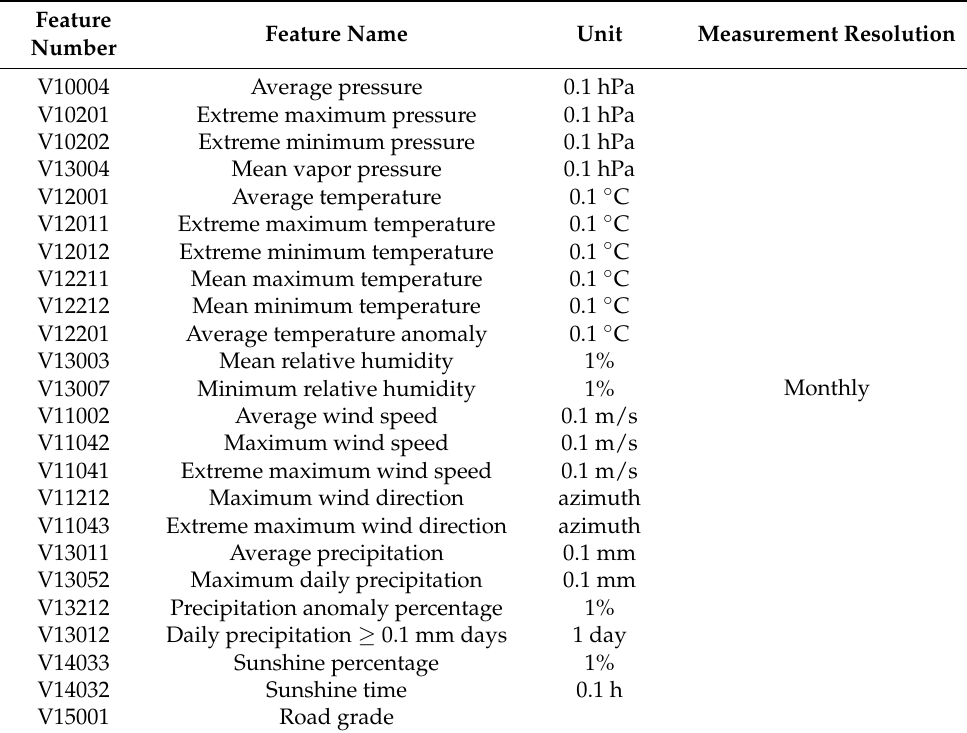
Table 3. Factors of meteorological data and units of